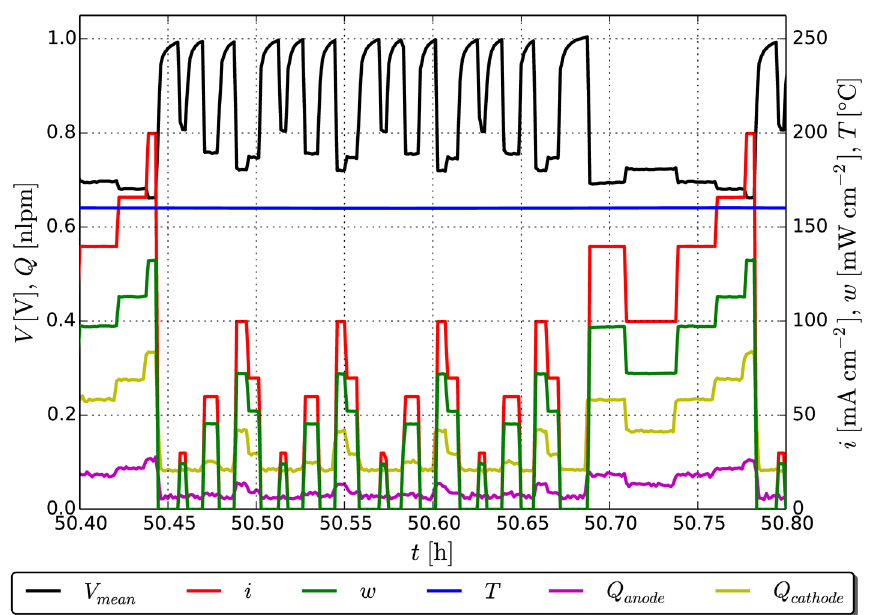
Fig. 1. Selected cycle of the test procedure. V mean is the cell mean voltage, i is the cell current density, w is the cell power density, T is the cell temperature, Q anode is the hydrogen volumetric flow on the anode side, Q cathode is the air volumetric flow on the cathode side, and t is time of the test